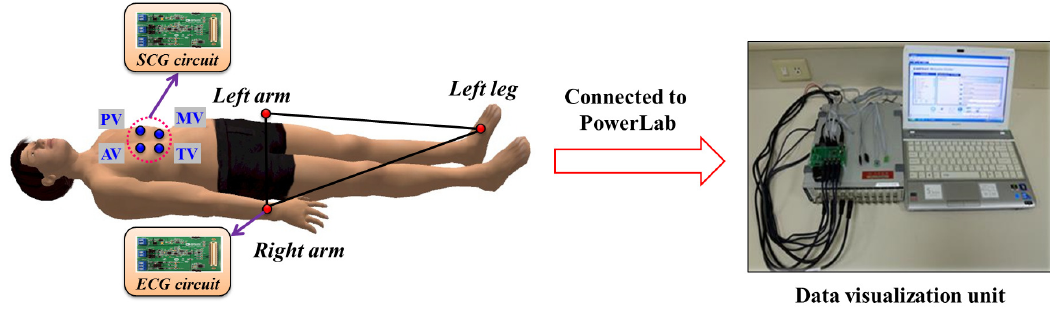
Figure 12. Architectural view of data acquisition